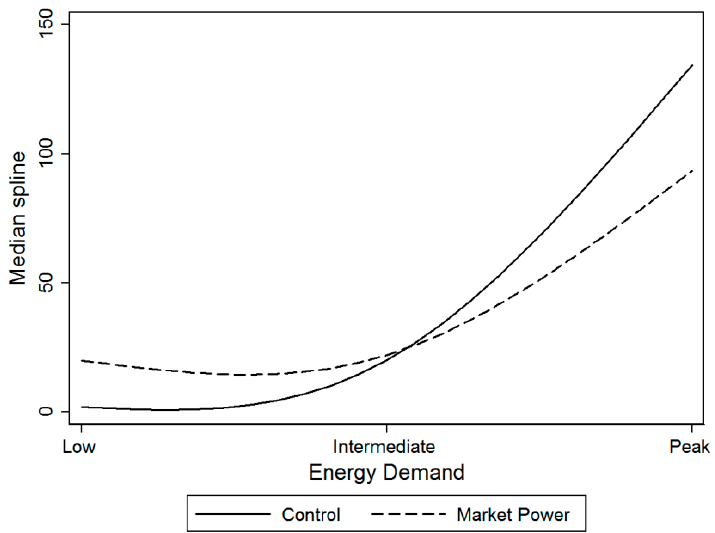
Figure 6. Median spline of treatment effect (with resale).